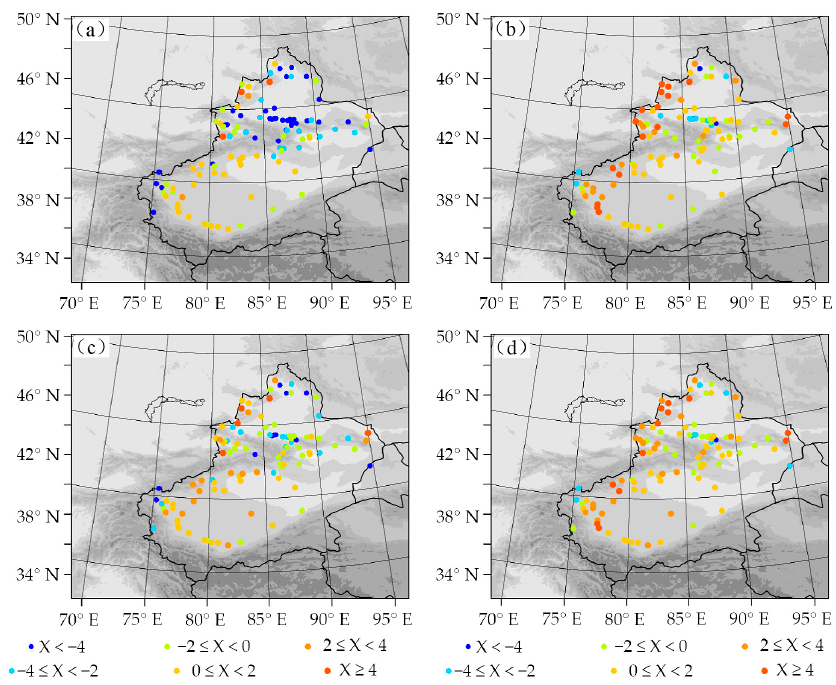
Figure 5. Monthly ME of the simulated soil temperature at 5 cm ( a , c ) and 25 cm thickness ( b , d ) in WRF simulations with Noah ( a , b ) and Noah-MP ( c , d ) scheme in January 2017 (unit: °C). Table 3. ME and RMSE of the simulated soil temperature at 10 cm and 30 cm thickness in WRF simulations with Noah and Noah-MP schemes in January and July 2017 (unit: °C).